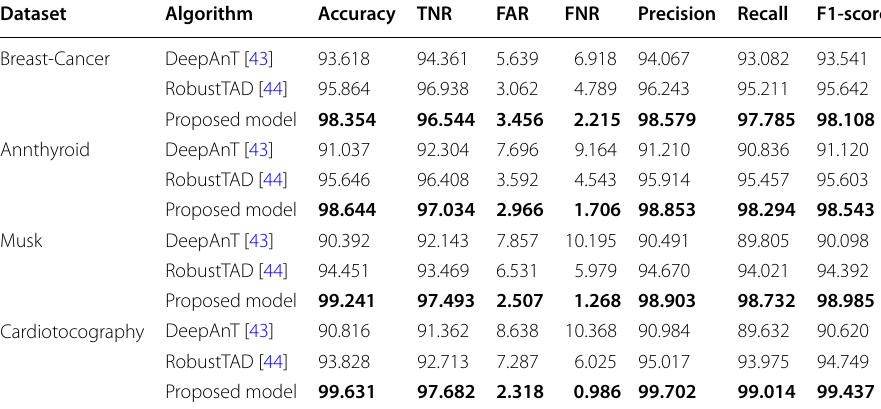
The highest scores are highlighted in bold